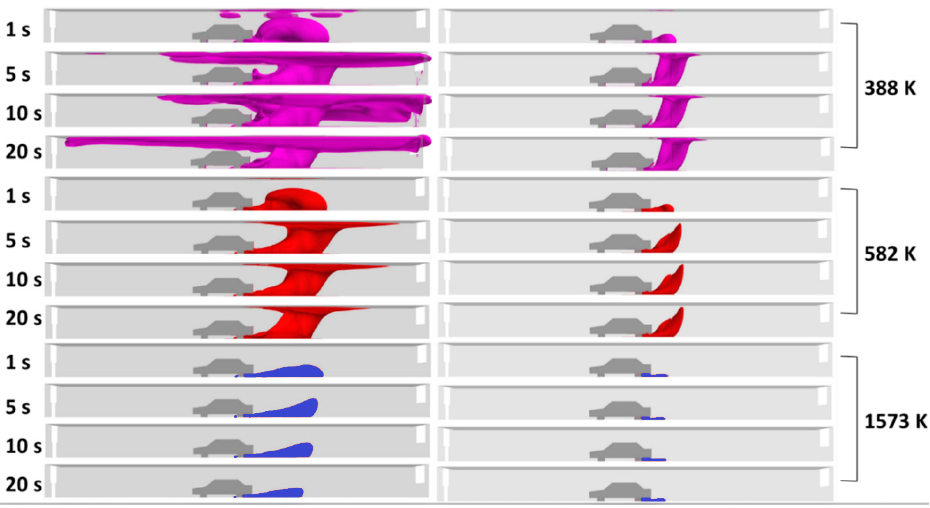
Figure 14. Side view iso-surfaces showing pain (388 K), fatality (582 K) limits and visible flame temperature (1573 K) for case 5 with TPRD = 2 mm ( left ), and case 10 with TPRD = 0.5 mm ( right ). Results from a 30° angle downward release from TPRD = 0.5 mm (case 10) are shown